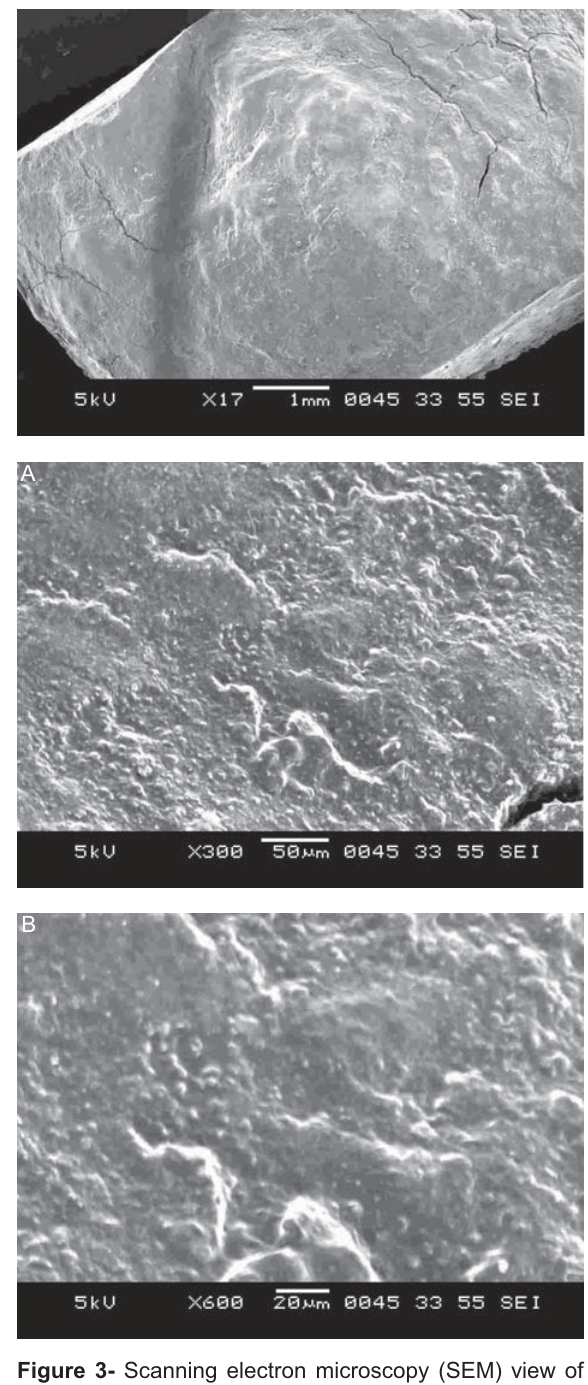
Figure 3- Scanning electron microscopy (SEM) view of group A sample. A: SEM view of group A sample at 300x